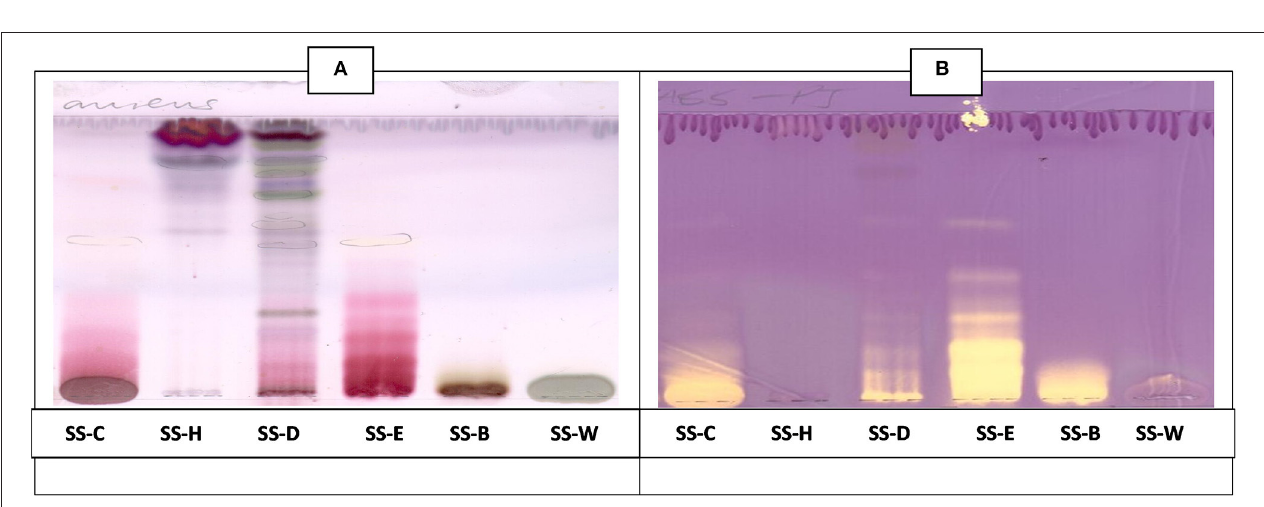
FIGURE 6 | (A) Chromatogram developed in CEF (7:3:0.5) of sub fraction DD2 and the 3 compounds sprayed with vanillin. (B) Bioautography of S. aureus of the 3 compounds. TLC developed in CEF (7:3:0.5). (C) Bioautography of E. coli of the 3 compounds. TLC developed in CEF (7:3:0.5). (D) Bioautography of S. Enteritidis of the 3 compounds. TLC developed in CEF (7:3:0.5). (B–D) Composite images of TLC plates run separately for each compound. C1, compound 1; C2, compound 2; C3, compound 3.